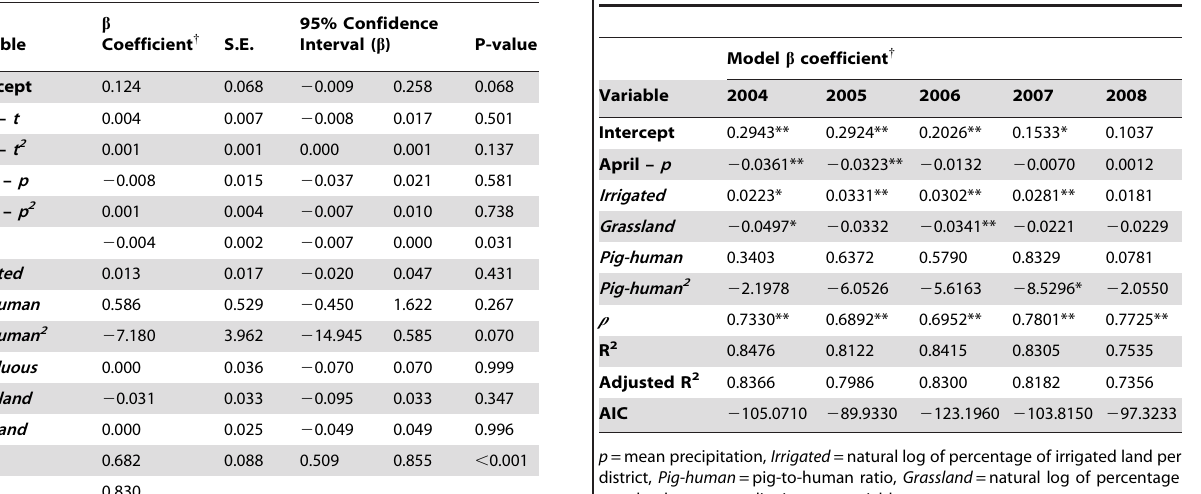
Table 2. Full model of 2005 district-level JE incidence as a function of climate, agriculture and land-use.